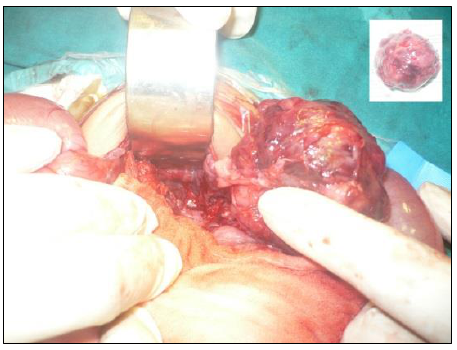
Figure 3: Presacral neuroblastoma. Inset shows complete